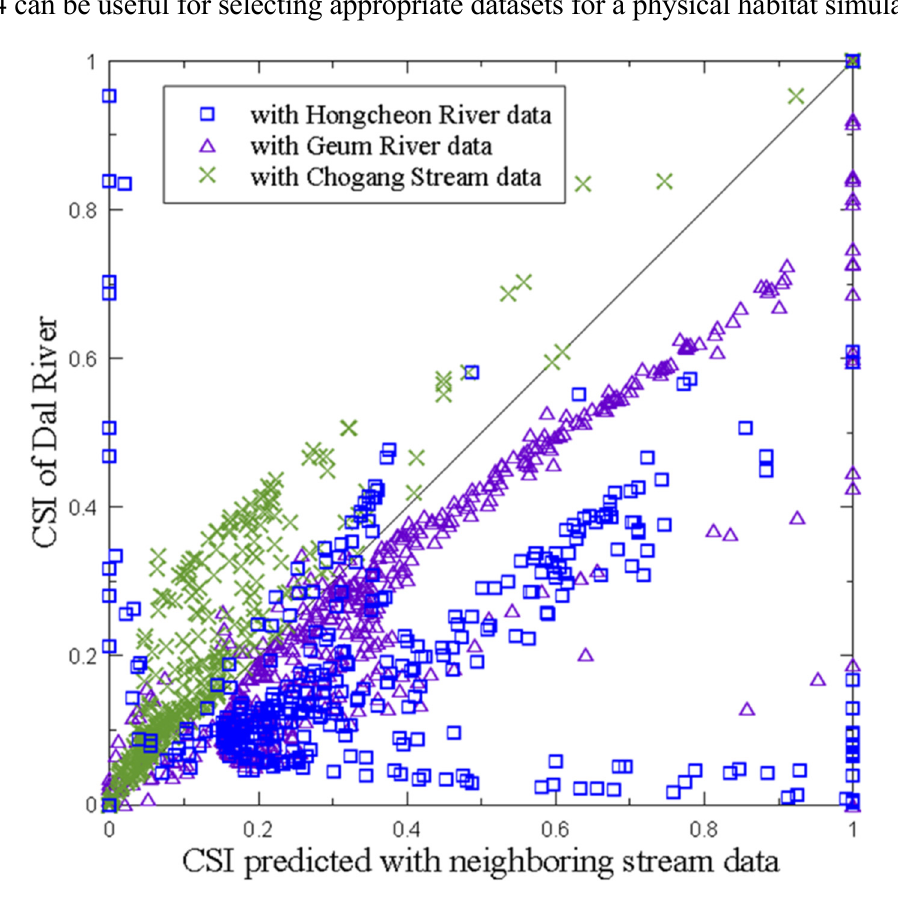
Figure 8. Comparison of predicted